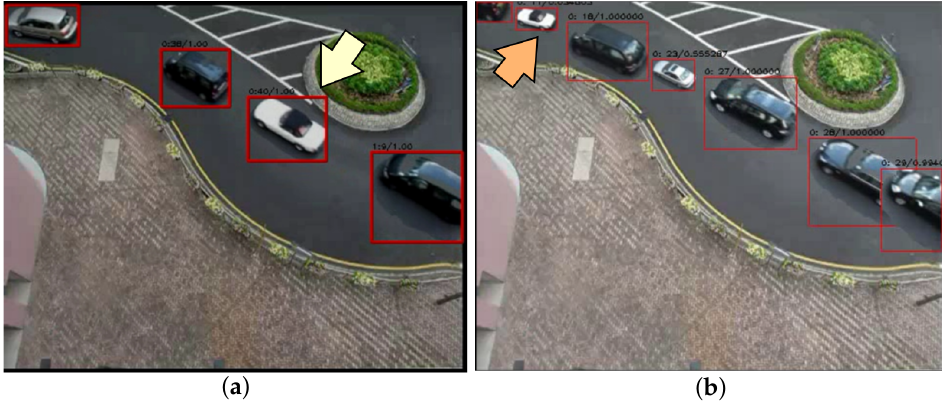
Figure 5. Frames in the synopsis video: ( a ) without a tube-resizing operation; ( b ) with dynamic and adaptive online tube resizing.